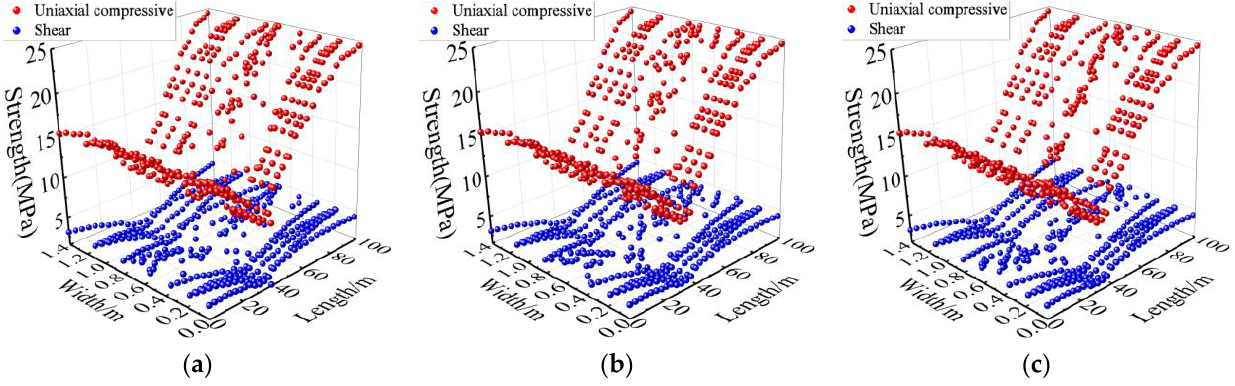
Figure 14. Uniaxial compressive strength and shear strength at different positions in the track bed: ( a ) surface; ( b ) middle; ( c ) bottom.